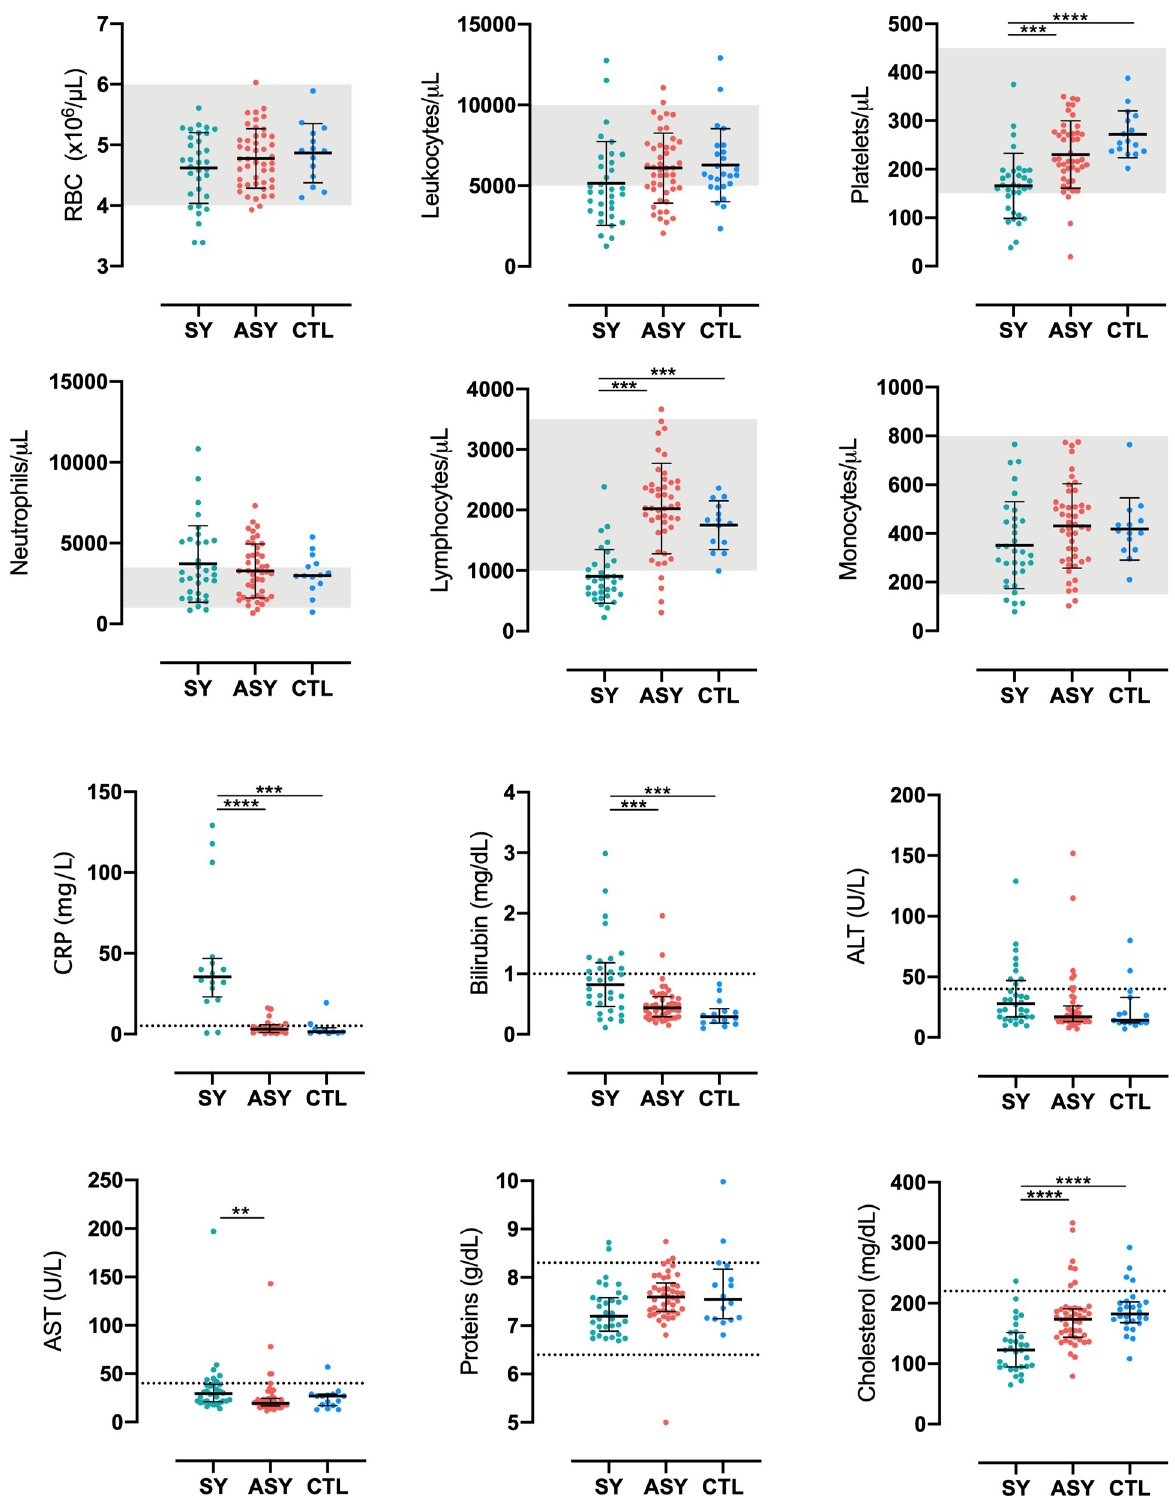
Fig 4. Asymptomatic individuals do not display hematological or biochemical alterations. Each dot represents individual values of each analyte by group. Gray background and dotted lines represent range of expected values in healthy individuals. Only significant differences were shown. � p < 0.05. �� p < 0.01. ��� p < 0.001. ���� p < 0.0001. Dunn’s test. SY–symptomatic patients. AS–Asymptomatic individuals. CTL—healthy controls. CRP–C-reactive protein. ALT–alanine transferase. AST–Aspartate transferase.